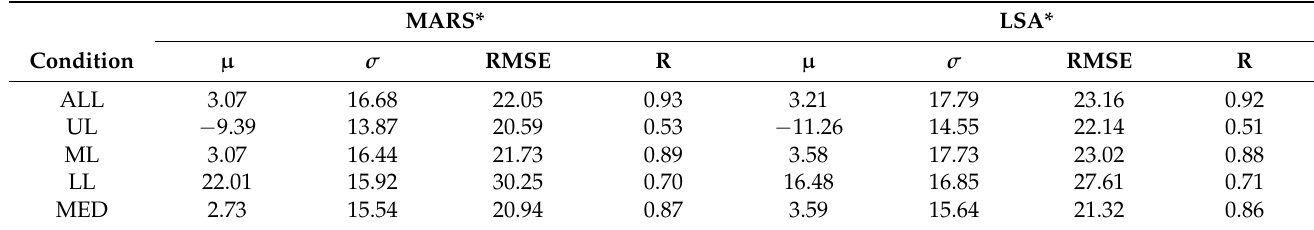
Table 4. Bias ( µ ), standard deviation of the error ( σ ), root mean square error (RMSE) and temporal correlation coefficient (R) between MARS and LSA models hourly estimates using ERA5 cloud infor- mation (MARS* and LSA*) against observations from all 23 ground stations for all-sky (2004–2019). Different conditions are considered for analysis: all data (ALL); observations with values